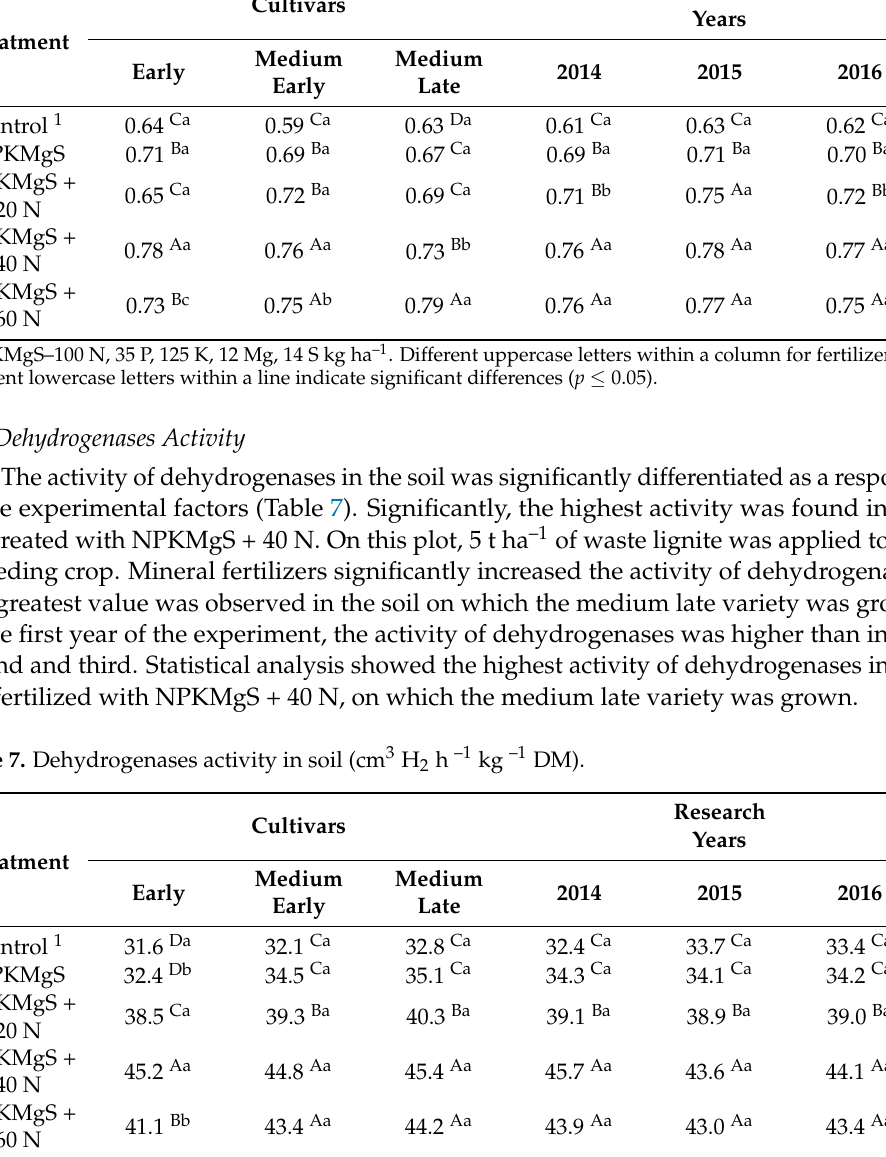
Table 6. Alkaline phosphatase activity in soil (mmol PNP h –1 kg –1 DM).